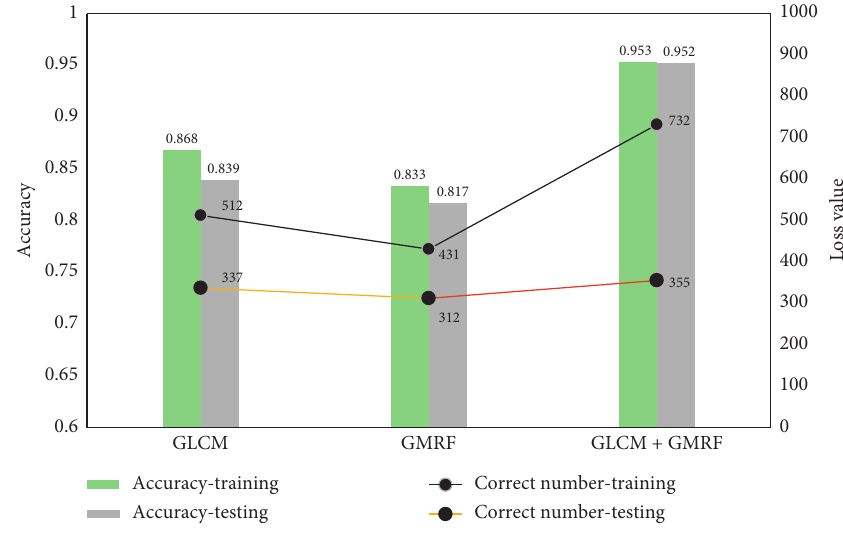
Figure 8: Classification accuracy of different feature inputs.